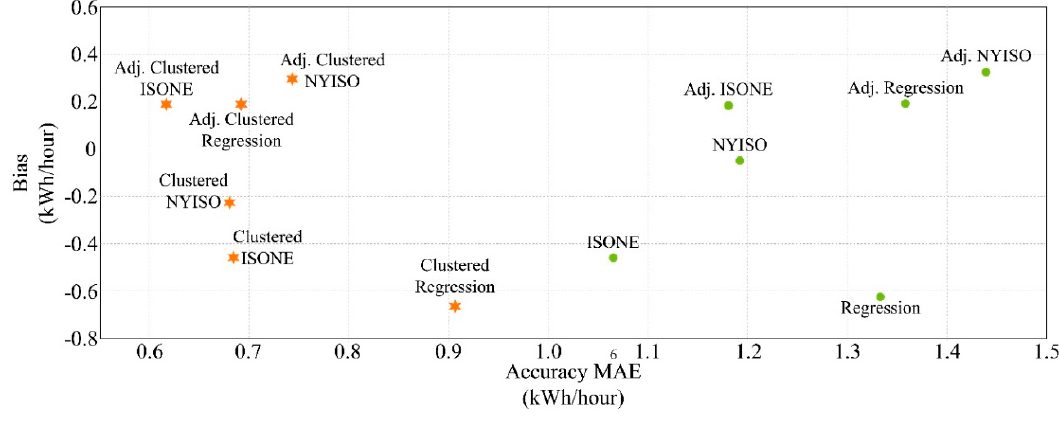
Figure 7. CBL method accuracy and bias for event hours.